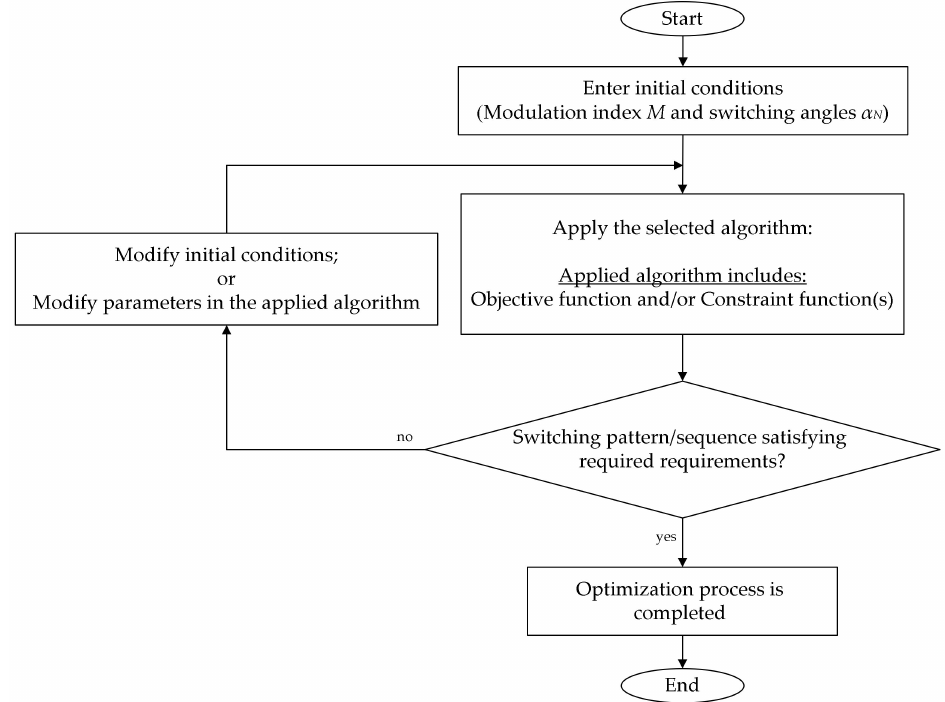
Figure 7. General structure of the solving process of